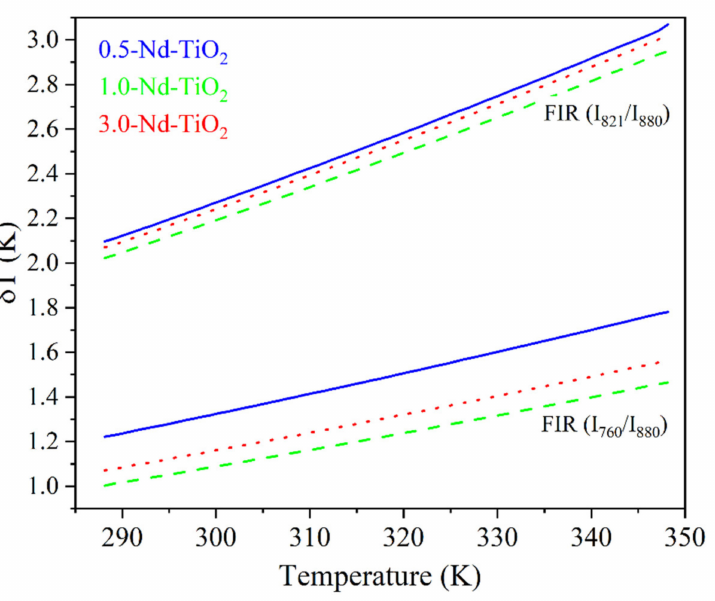
Figure 9. Thermal resolution calculated using Equation (3) of x -Nd–TiO 2 ( x = 0.5, 1.0 and 3.0 wt.%)